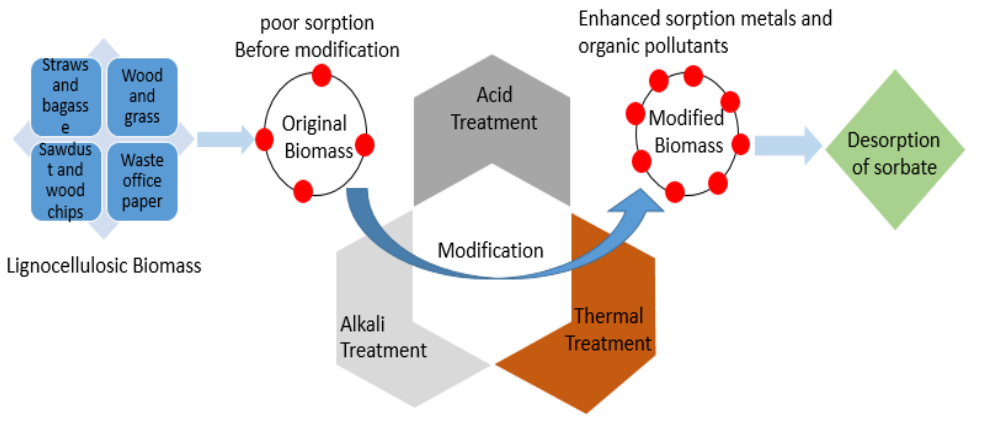
Figure 2. Illustration of use of biosorbents in removal of pollutants.